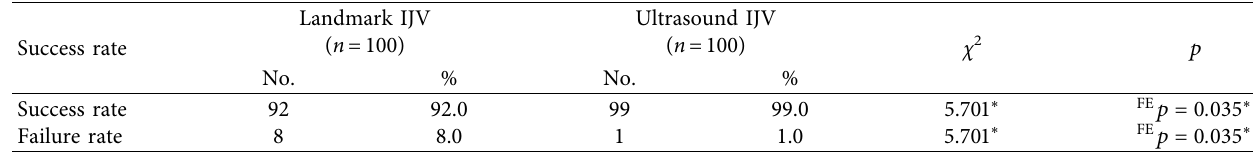
Table 4: Comparison between landmark and ultrasound techniques in IJV group (A) according to success rate.